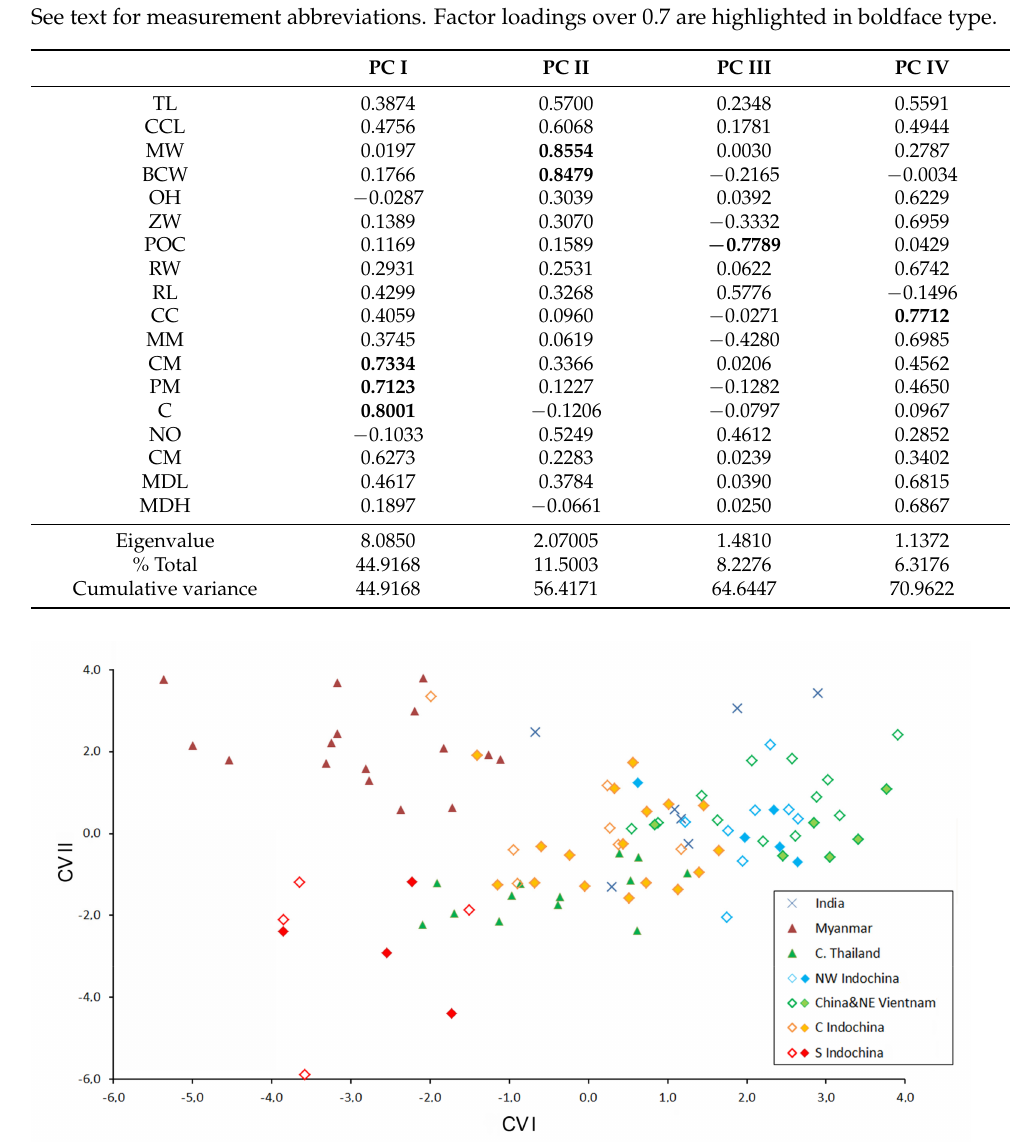
Figure 6. Bivariate scatter plot for the first and second canonical variances of a Discriminant Function analysis based on 18 cranial and dental measurements of six training sets of Hipposideros pomona s. lato. All Indian specimens were included as “undetermined.” Specimens marked by closed diamonds were genotyped with at least one mitochondrial gene. Table 5. Phenetic (squared Mahalanobis) distances between training sets (above diagonal) and significance of difference between them ( p -level, below diagonal) calculated in a forward stepwise Discriminant Function analysis. Cases of insignificant difference re highlighted in boldface